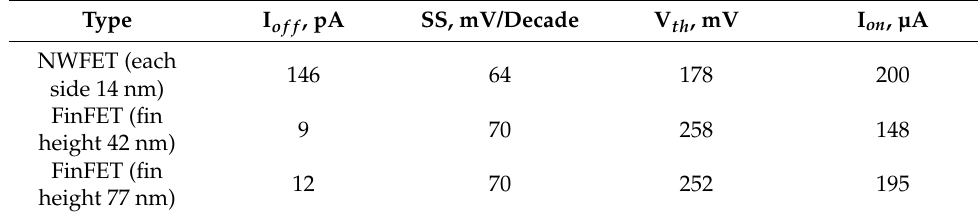
Figure 7. Drain-gate I d -V gs characteristics: the dots indicate experimental data of NWFET, the main line is the results of NWFET TCAD modeling, the dotted line is the results of FinFET TCAD modeling (fin height 42 nm), the dashed line is the results of FinFET TCAD modeling with an increased fin height 77 nm; for all cases V ds = 1.2 V. Table 1. Comparison of the main parameters of NWFET and